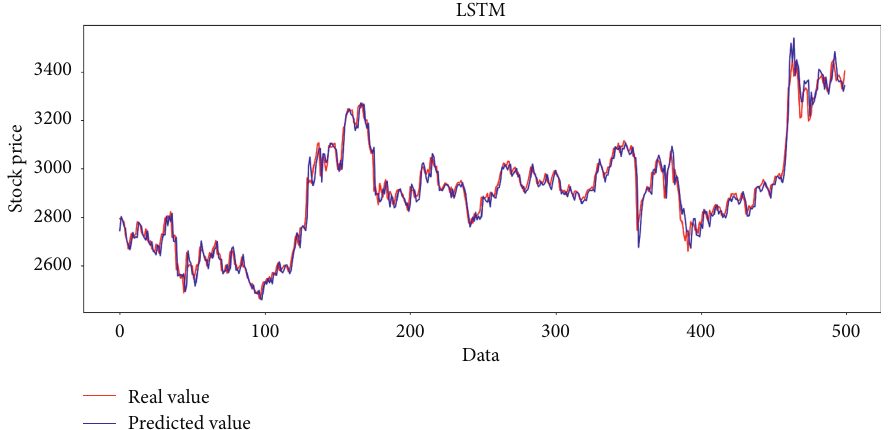
Figure 8: Comparison of the predicted value and the real value for LSTM.